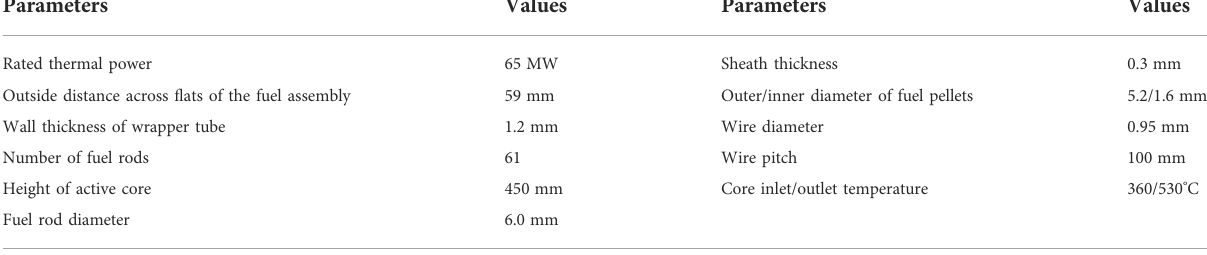
TABLE 1 Main parameters of CEFR.